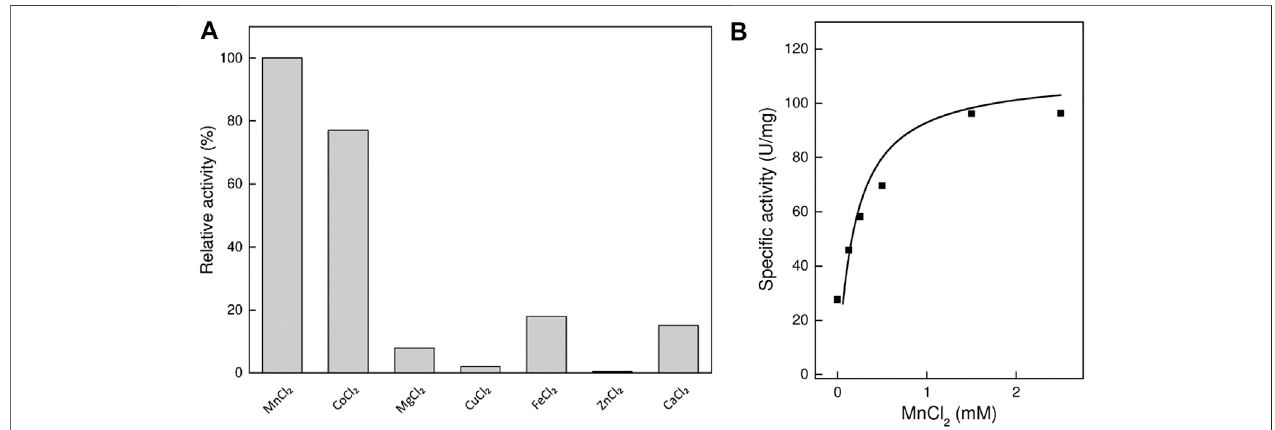
FIGURE 3 | Effect of divalent cations on the activity of TsLI. (A) Relative activity with different divalent cations (1 mM) (100% (cid:2) 60 U/mg) The assay (600 µL) was performed at 95 ° C in50 mM BisTrisbuffer, pH 7.0, 50-mM D-lyxose and 6.48 µgenzyme. (B) Rate dependency on theMnCl 2 concentration. The assays(400 µL) were performed at 95 ° C in 50 mM BisTris buffer, pH 7.0, 50 mM D-lyxose and 5.06 µg enzyme. The kinetic constants were fi tted to the Michaelis-Menten equation using the calculated standard errors; the Vmax, and Km values were 105 ± 9.9 U/mg and 0.19 ± 0.08 mM, respectively.